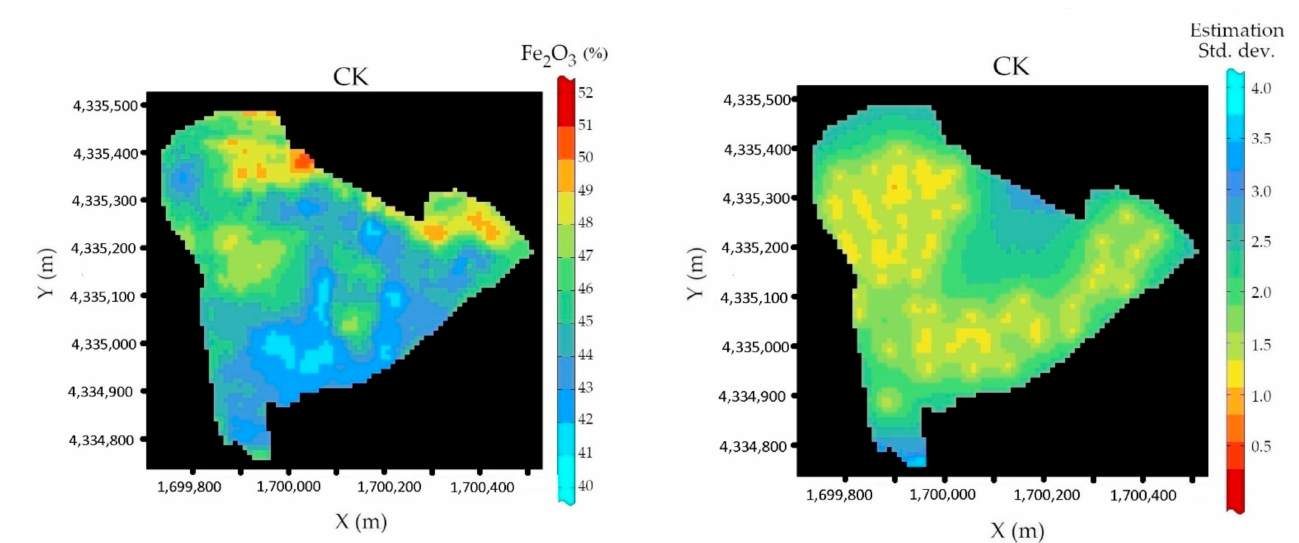
Figure 8. Fe 2 O 3 (%) estimated map ( CK ) ( left ) and the estimation variance map ( right ) by performing co-kriging between samples and ferrous iron oxide band